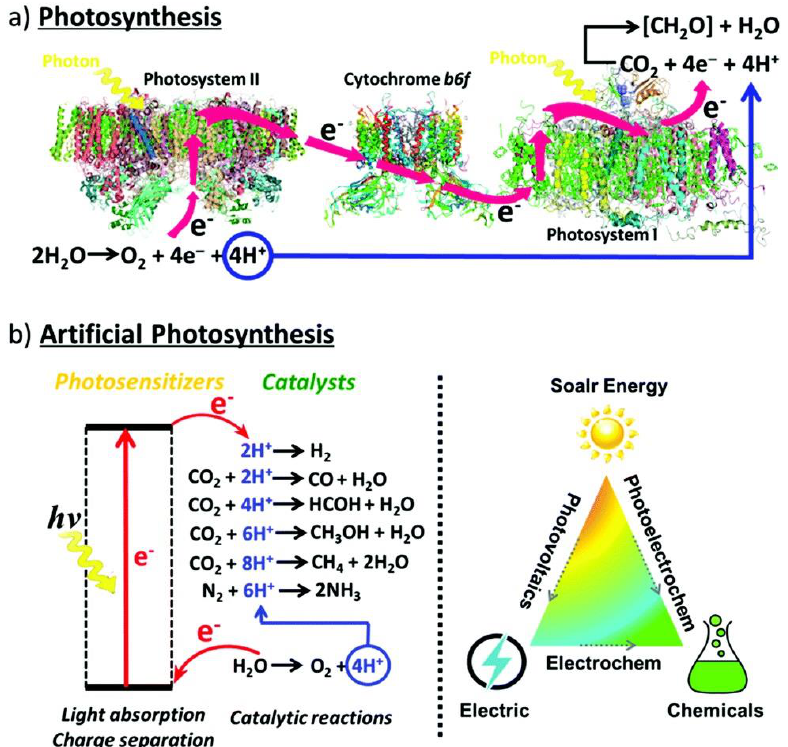
Figure 1. ( a ) Photosynthesis is enabled through the collaborative efforts of two photosynthetic complexes, PSI and PSII, where PSI serves as the reaction center and light harvesting complex and PSII is the site of water oxidation. Thus, H 2 O is oxidized in PSII into O 2 releasing four protons and electrons, respectively, that are transferred via cytochrome b6f, an enzyme in plant chloroplasts, to PSI where they are consumed by CO 2 reduction to produce carbohydrates. ( b ) Artificial photosynthetic systems for photocatalysis are being developed to mimic and provide for the very same conversion of solar energy through alternative energetic pathways and selectivity for fundamental and desirable chemical reactions, including water splitting, CO 2 photoreduction, and the degradation of harmful organic pollutants. Reprinted with permission from Ref [10] with attribution and adherence to Creative Commons Attribution-NonCommercial 3.0 Unported Licence. Copyright Royal Society of Chemistry